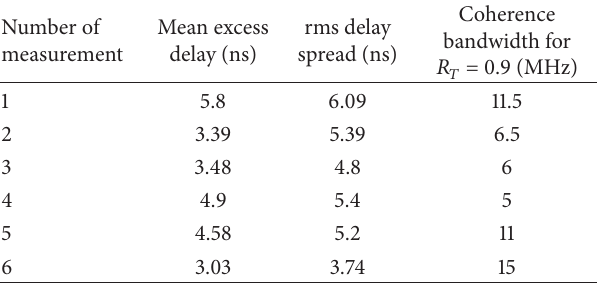
Table 2: Wideband parameters in each measurement experiment.